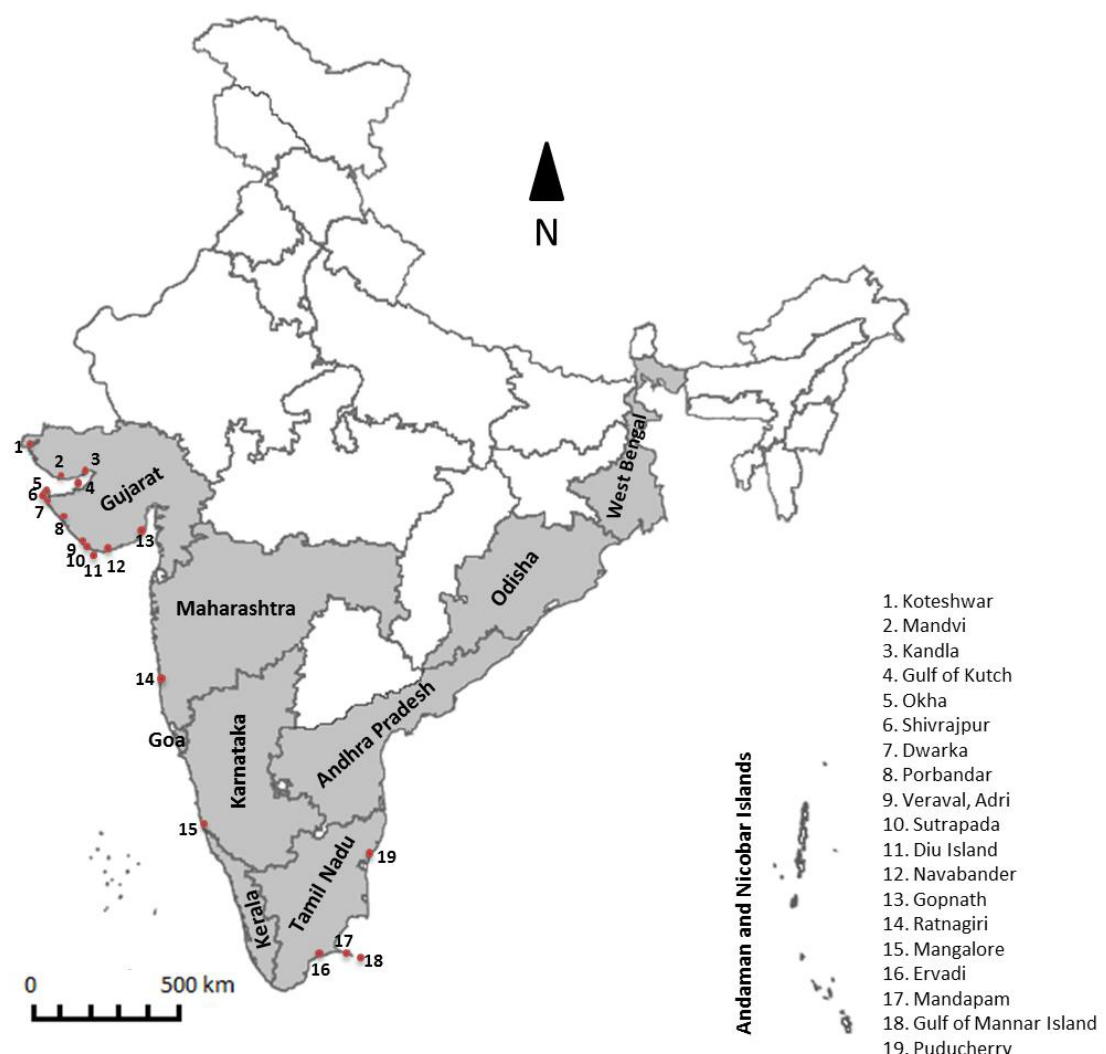
Figure 3. Di ff erent coastal states and sites surveyed for seaweed biodiversity in Figure 3. Different coastal states and sites surveyed for seaweed biodiversity in India.